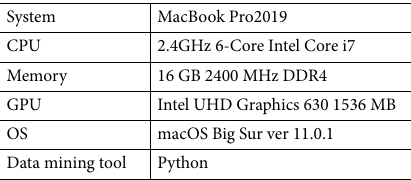
Table 4. System configuration.